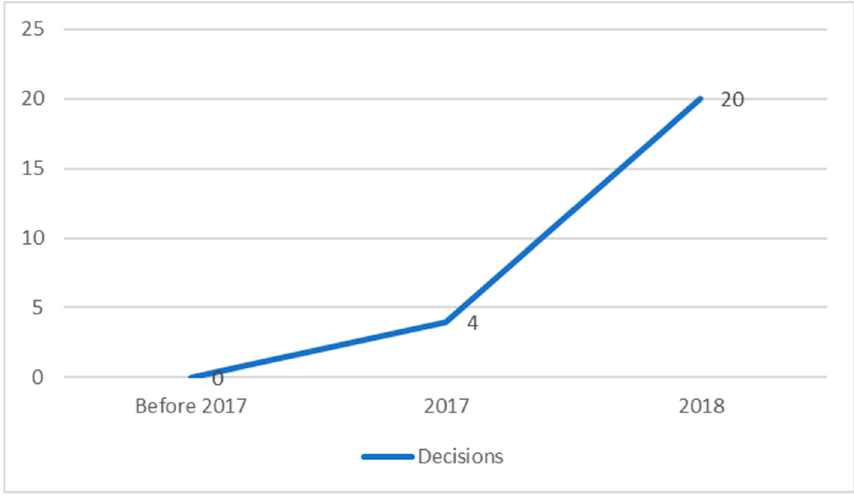
Figure 11. References to UN’s Resolutions over the Years.